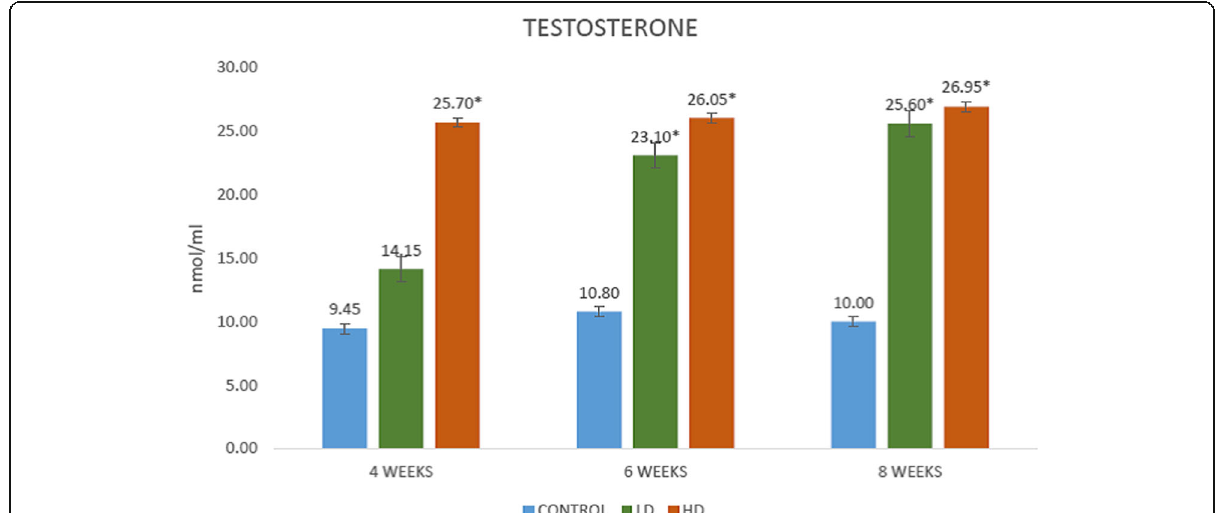
Fig. 5 Effect of administration of aqueous root extract of Chrysophyllum albidum on serum concentration of testosterone of the experimental rats at the 4th, 6th and 8th week of the experiment. Bars represent Mean ± SEM. n = 5. *Superscript shows Mean with significant ( P < 0.05) difference within each week